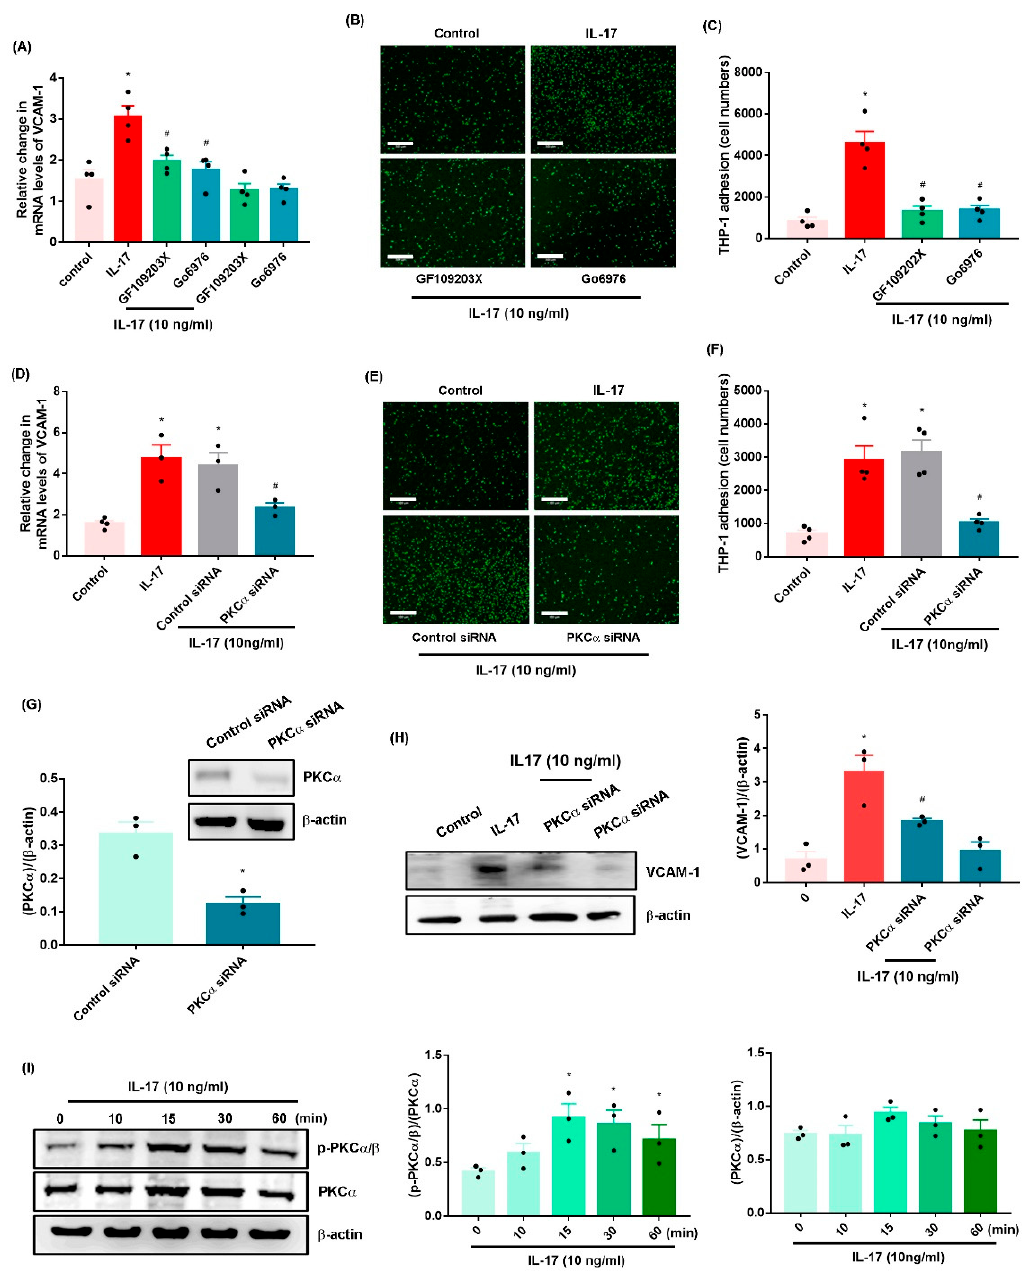
Figure 3. The PKC- α pathway mediates IL-17-induced promotion of VCAM-1 synthesis and monocyte adhesion in OASFs. ( A , D , H ) OASFs were stimulated with PKC inhibitors (GF109203X, 10 nM and Gö6976, 10 nM) for 30 min or transfected with a PKC- α siRNA for 24 h and then treated with or without IL-17 (10 ng/mL) for 24 h. Quantification of VCAM-1 expression was performed by qPCR and Western blot. ( B , C , E , F ) Adherent THP-1 cells were photographed and quantified under fluorescence microscopy. ( G ) PKC- α protein levels were measured by Western blot. ( I ) OASFs were stimulated with IL-17 for the indicated time intervals. PKC- α phosphorylation was performed by Western blot. Size bar = 320 µ m. * p < 0.05 compared with the control group; # p < 0.05 compared with the IL-17-stimulated group.